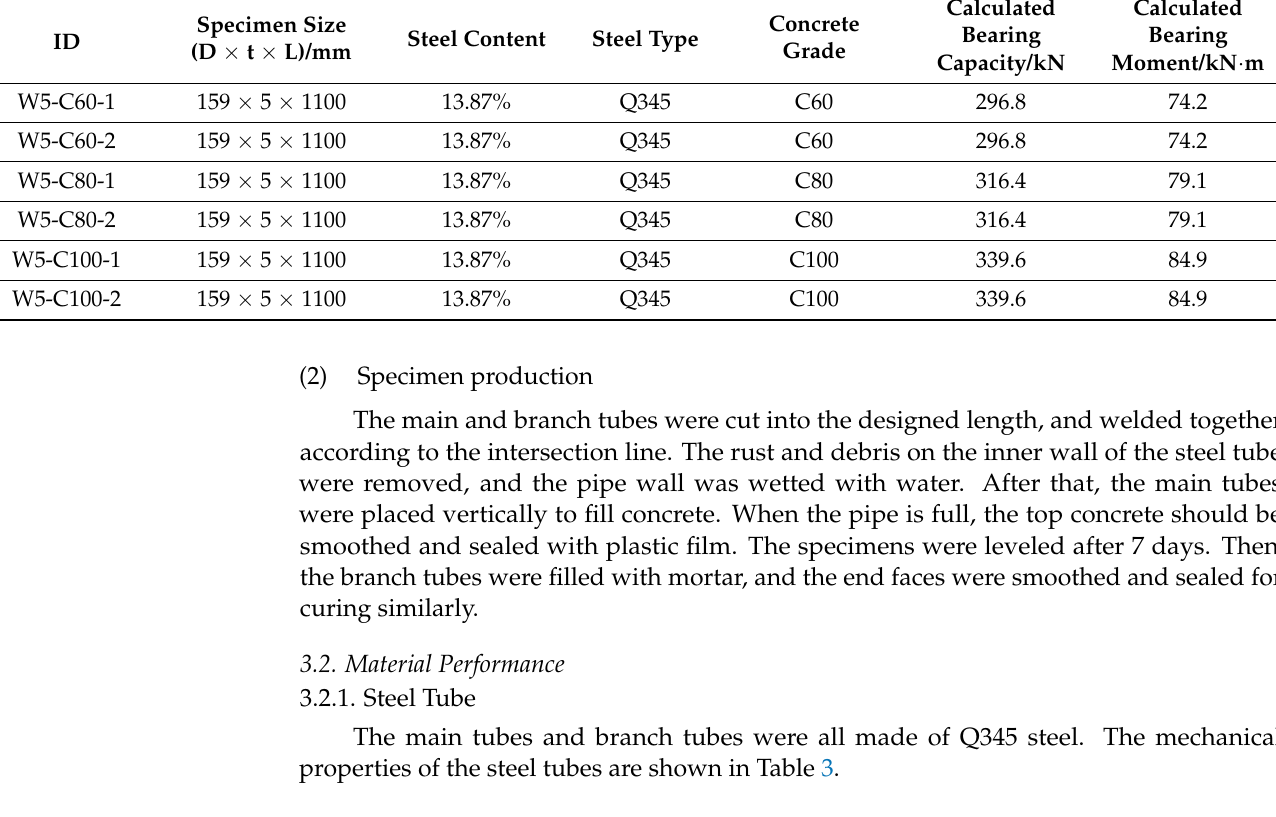
Table 3. Mechanical properties of the steel tubes.